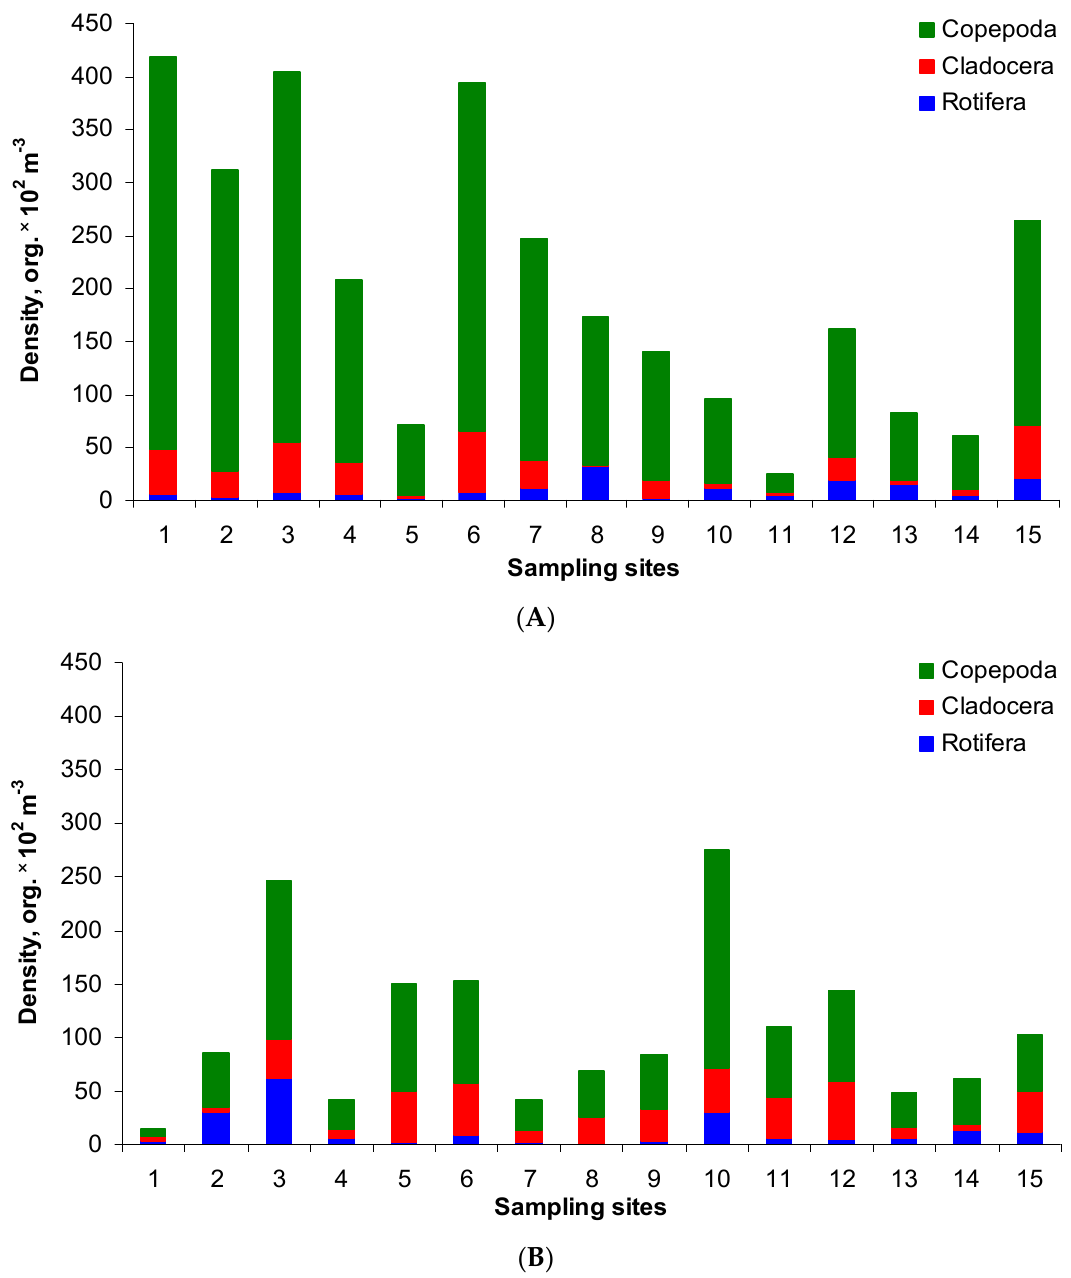
Figure 3. Zooplankton density and structure in the post-flood period ( A ) and the pre-flood period ( B ) in the main channel of Lake Nasser; sampling sites 1–15 concern five sectors and their eastern, middle and western parts, with detailed information in Table 1.